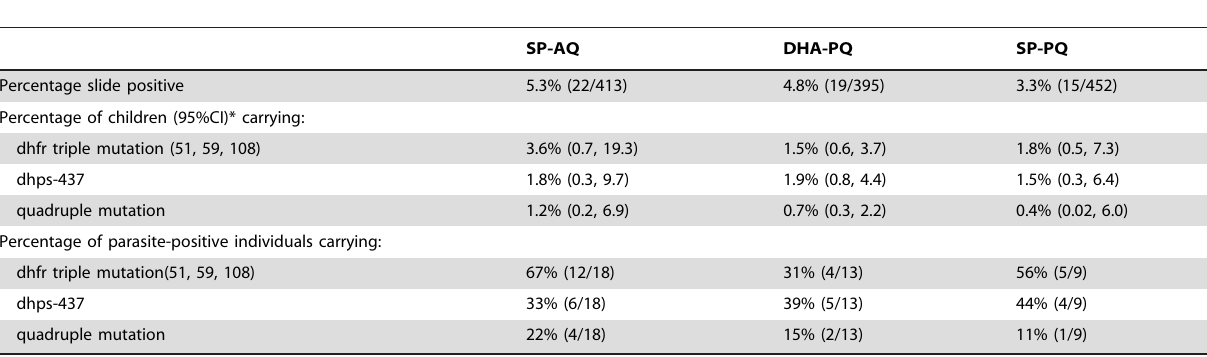
Table 5. Prevalence of parasitaemia and of molecular markers of resistance to SP at the end of the transmission season.